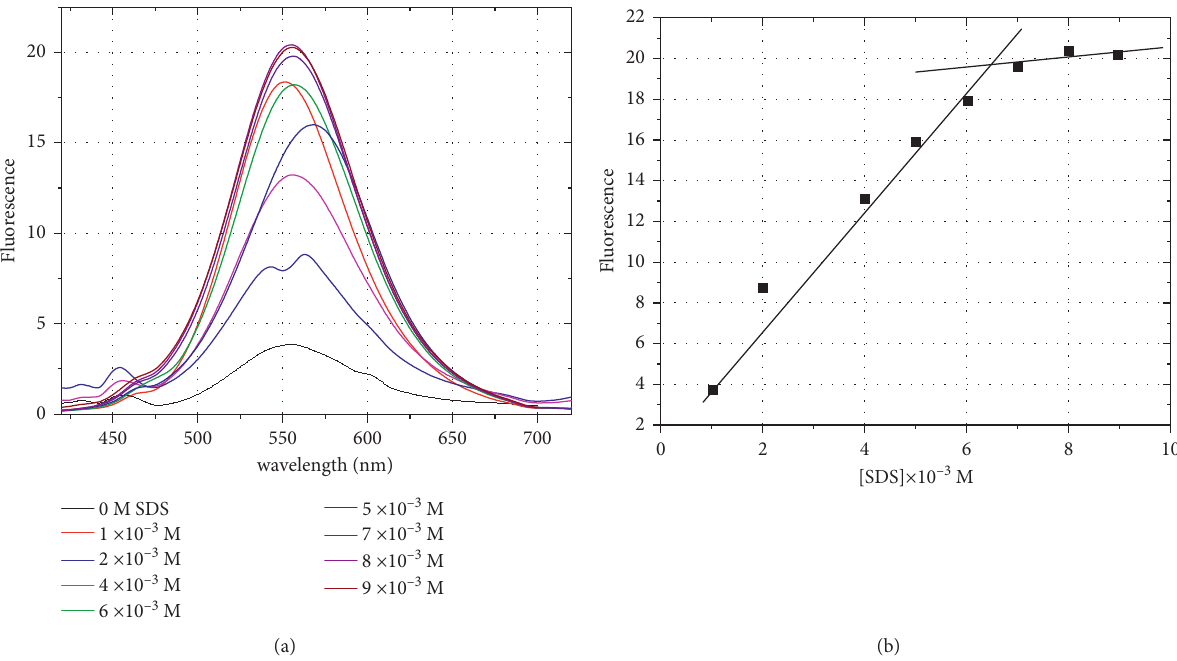
Figure 15: Absorption spectra (a) and fluorescence spectra ( λ different glycerol